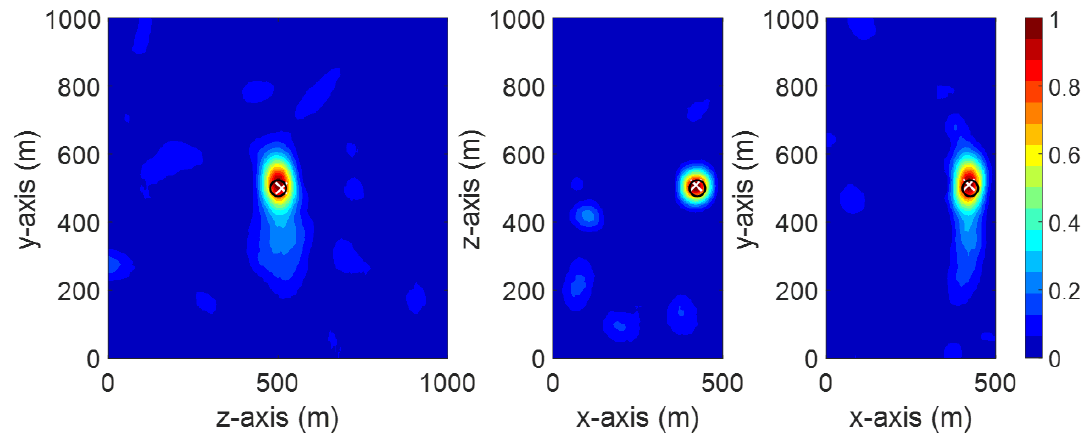
Figure 10. The geometry of the transformer tank including transformer windings and metallic core. Table 3. Location of the considered sensor and PD source inside the transformer tank, including the transformer winding and metallic core.